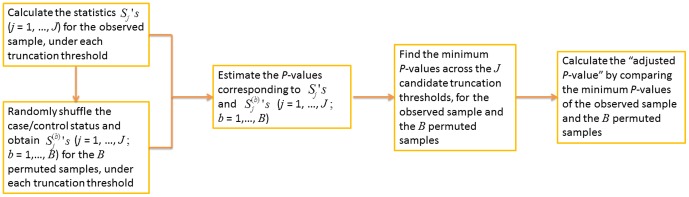
The workflow diagram of the ADA method.